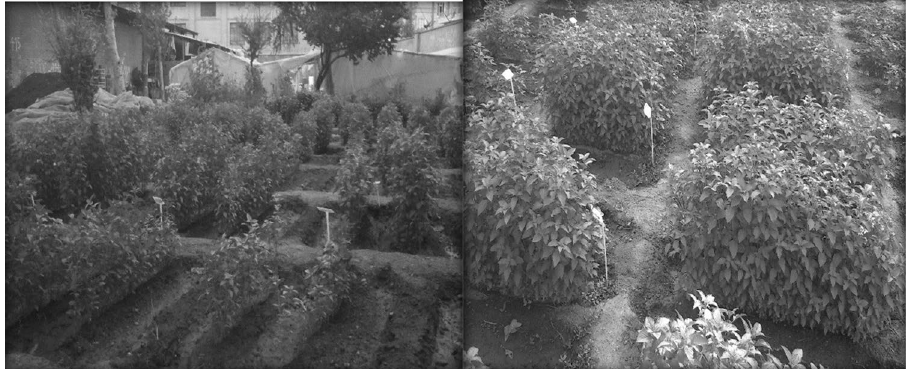
Fig. 2 An overview of the test at the Doshan Tappeh research